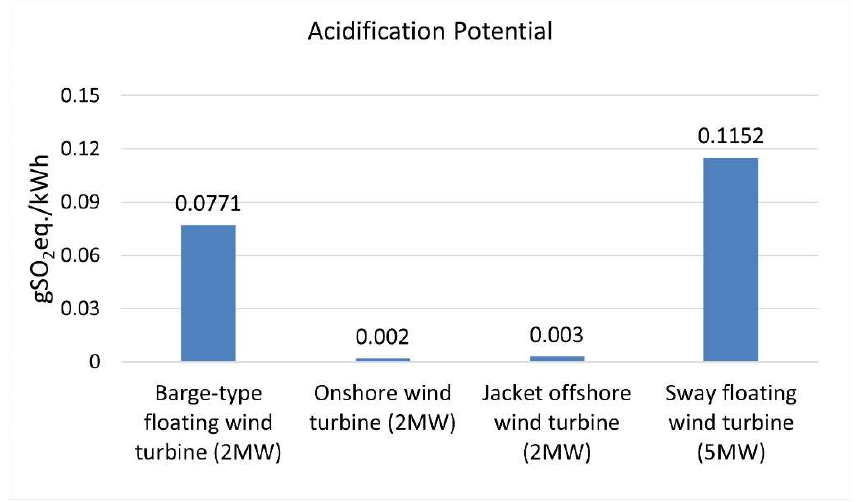
Figure 8. Total acidification potential for floating, onshore, and offshore wind turbine.